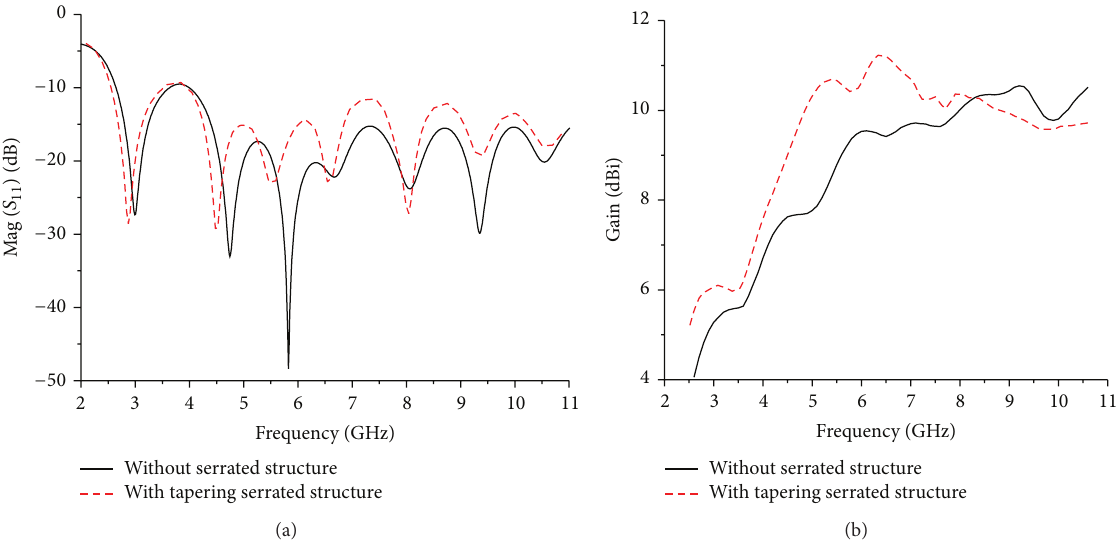
Figure 2: (a) Simulated reflection coefficient versus frequency for two structures. (b) Simulated gain versus frequency for two structures.